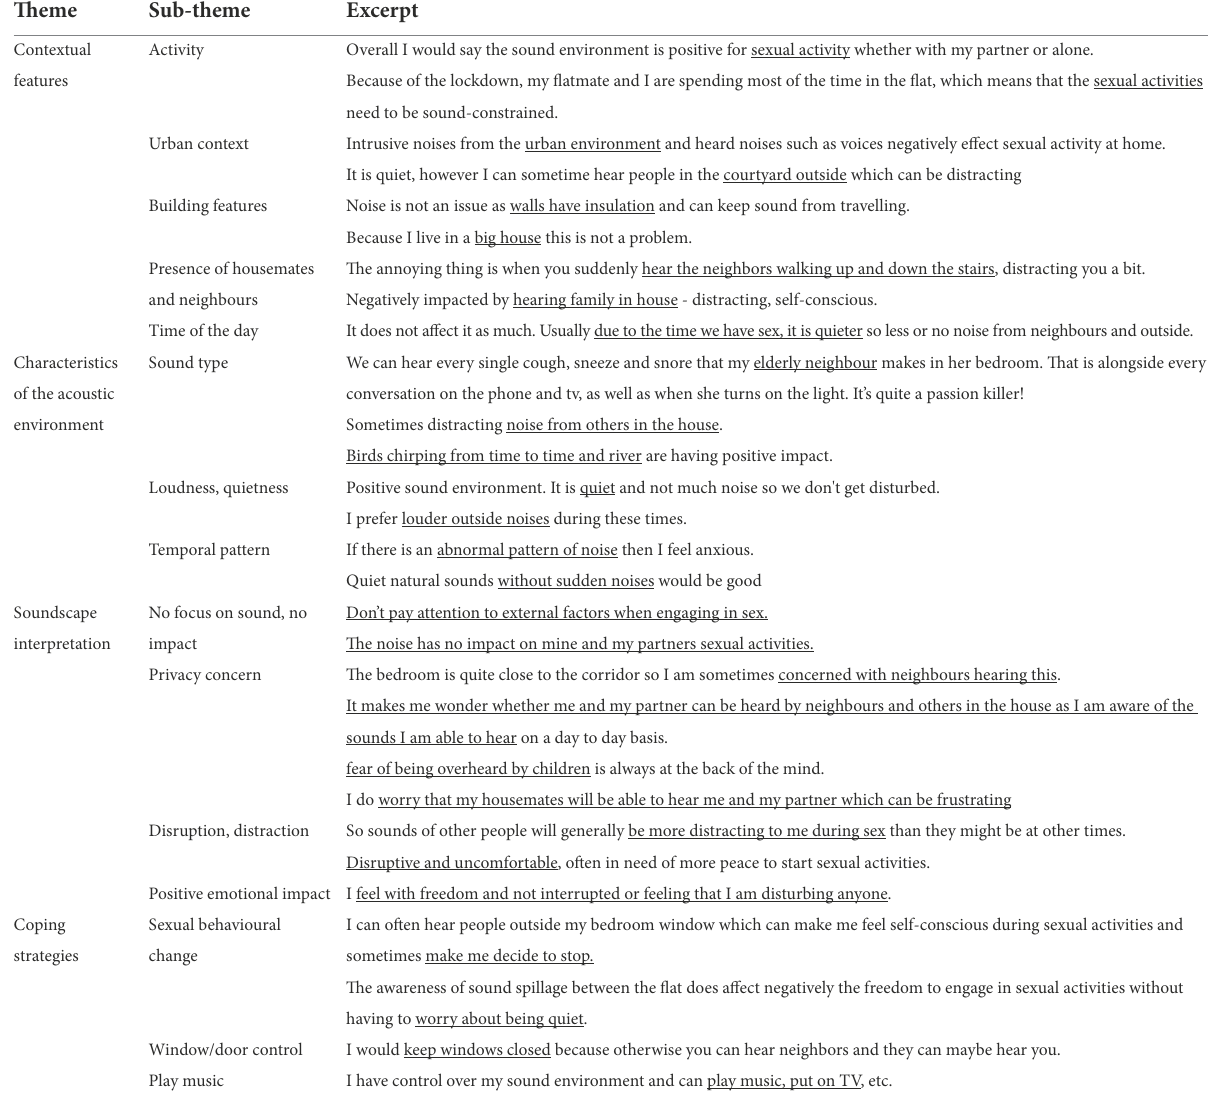
TABLE 5 Example of excerpts and coded fragments (underlined in the table) related to themes and sub-themes defined from the thematic analysis for soundscape impacts on sexual